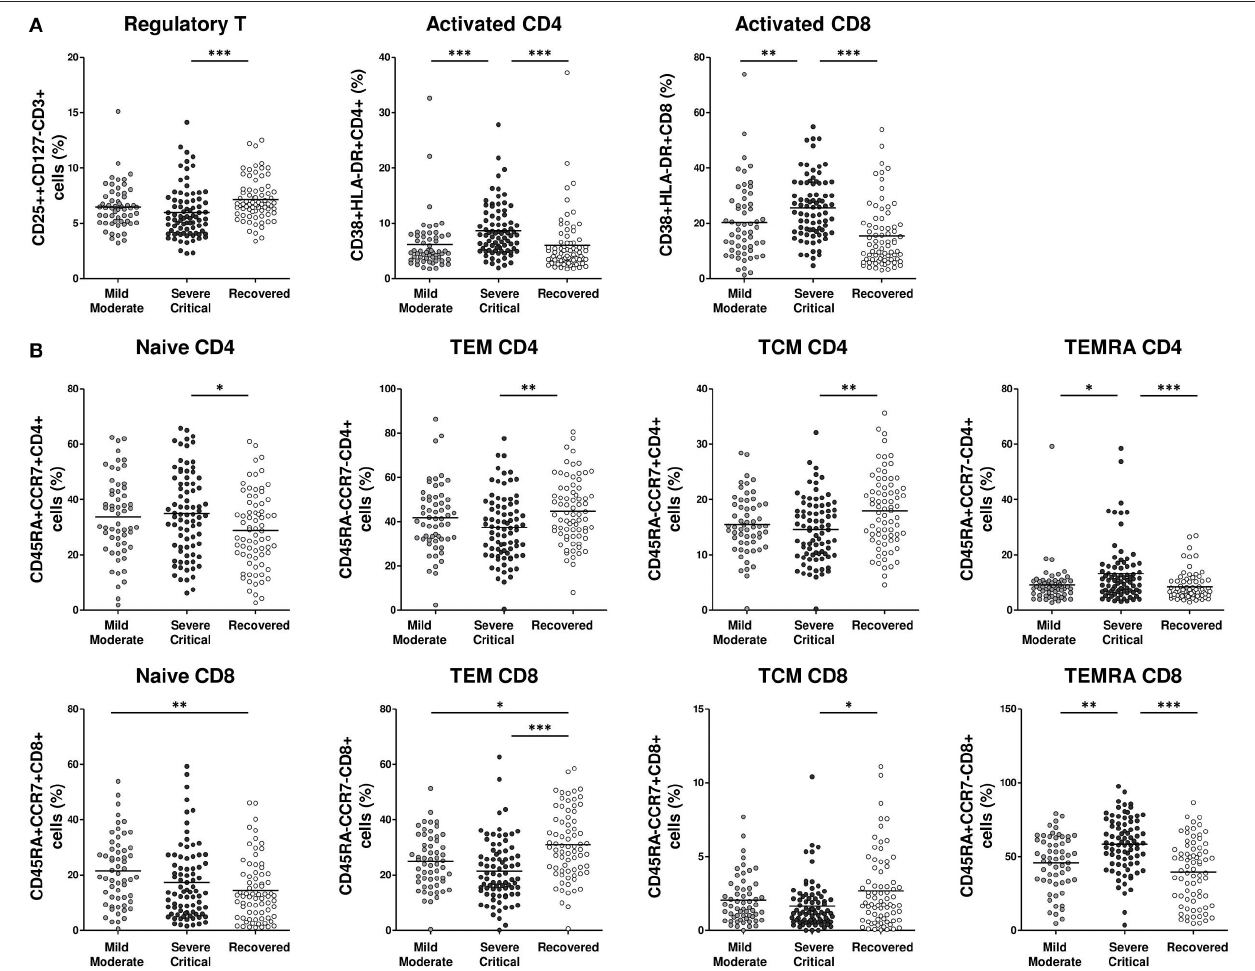
FIGURE 2 | Lower regulatory T cells and higher activated (CD38 + HlA-DR + ) and EMRA phenotype CD4 and CDS frequency in severe/critical COVID-19 patients. Frequency of selected peripheral blood T cell populations (A,B) in mild/moderate (light gray circles), severe/critical (dark gray circles) and recovered (white circles) groups of patients. Each dot represents an individual patient. Data are given as mean (Kruskal–Wallis test P- values: * P < 0.05; ** P < 0.01; *** P < 0.001). TEM, T effector memory; TCM, T central memory; EMRA, terminally differentiated effector memory cells